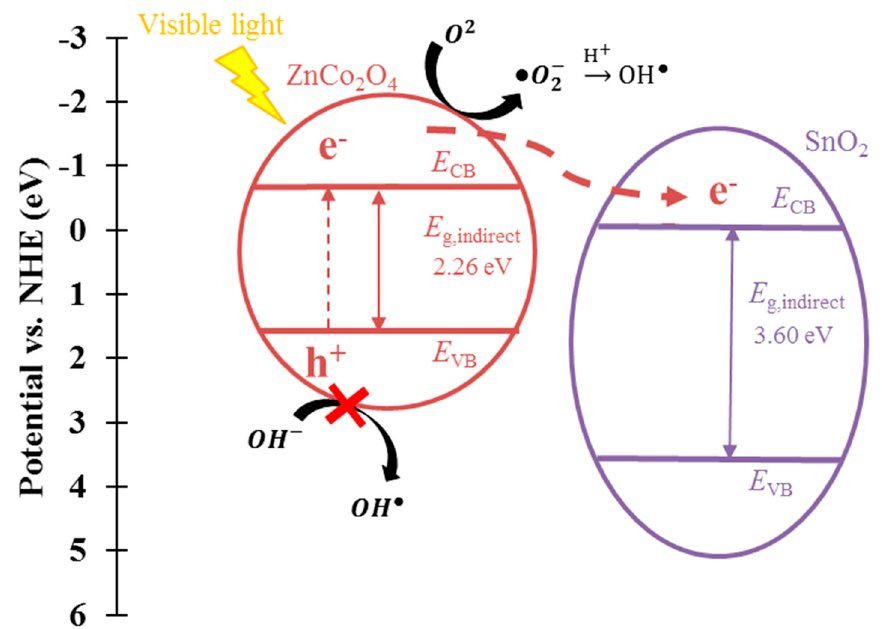
Figure 10. Mechanism of charge transfer in mixed SnO 2 -ZnCo 2 O 4 sample. Electrons (e − ) and holes (h + ) correspond to the photogenerated electron and hole, E CB and E CV stand for potentials of conduction and valence band, E g,indirect corresponds to the indirect band gap.